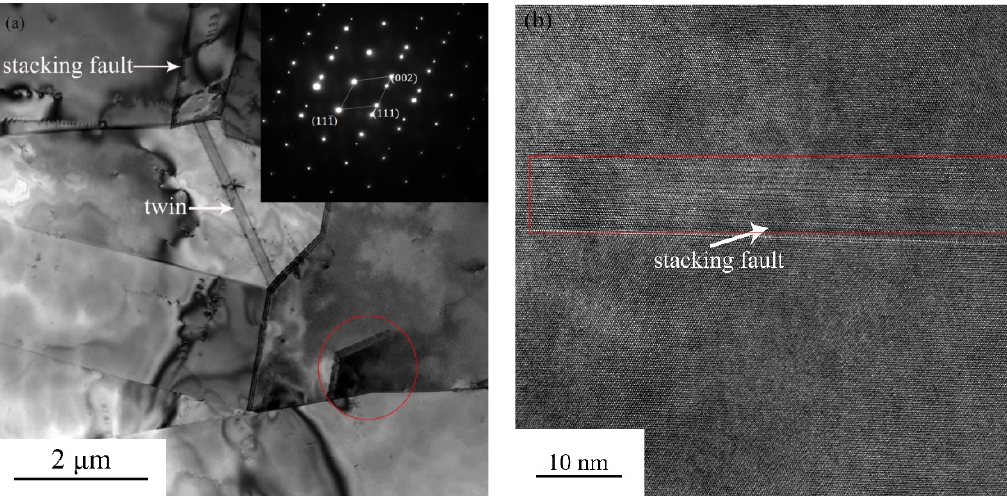
Figure 15. The TEM bright field photograph of Ni-36.6W-15Co after annealing at 1150 °C for 10 min, ( a ) selected area diffraction patters (SADP) of the twin and ( b ) is HRTEM image of the stacking fault.